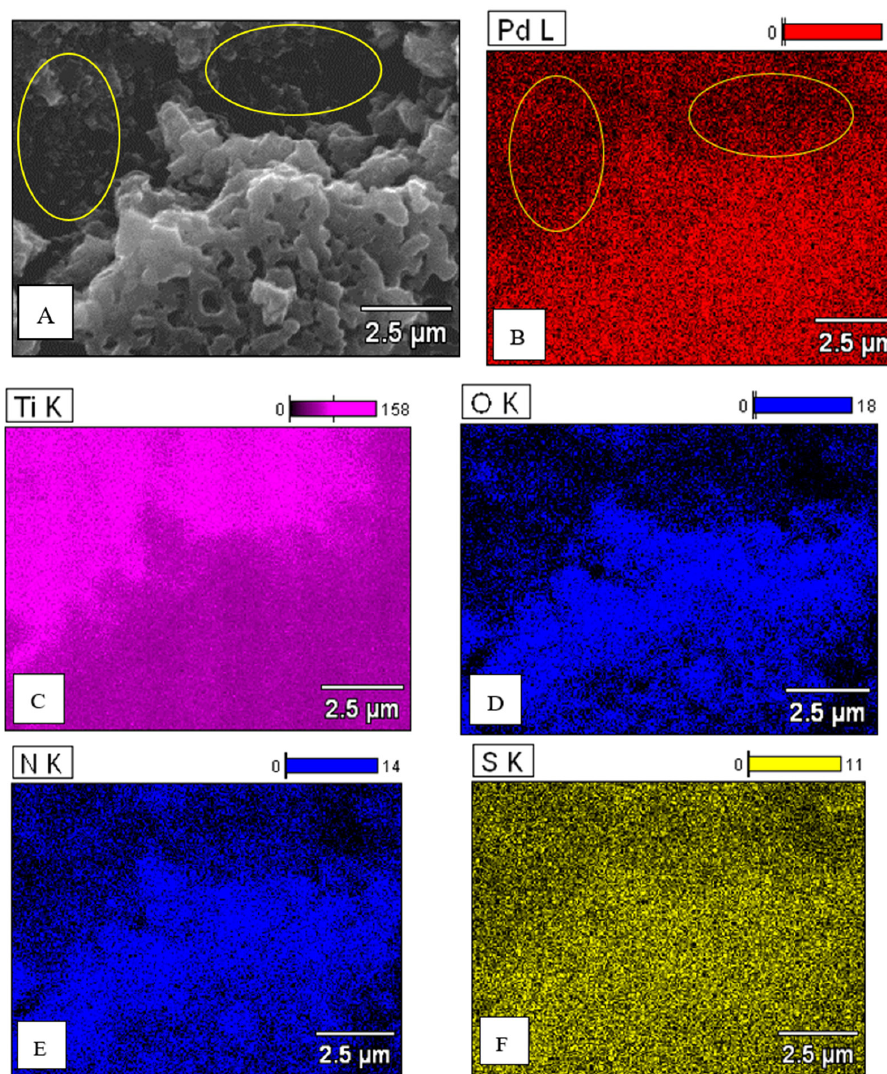
Figure 11. Scanning electron microscope–energy dispersive spectrometry (SEM-EDS) images of Pd/TiO 2 /Ti catalyst obtained with adsorption of Pd ions from 2% Pd wt. solution. ( A ) images; ( B – F ) elemental analysis.